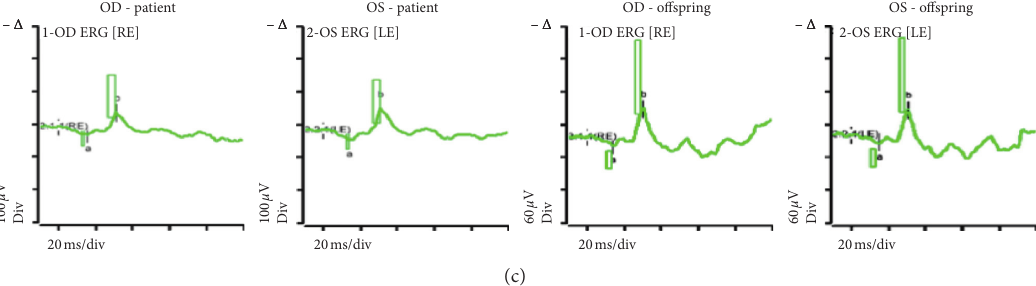
Figure 6: Full-field ERG of the patient and her offspring, demonstrating abnormal electroretinal function of the rod and cone systems. (a) Scotopic 0.01 averaged ERG, (b) scotopic 3.0 averaged ERG, and (c) photopic 3.0 averaged ERG.